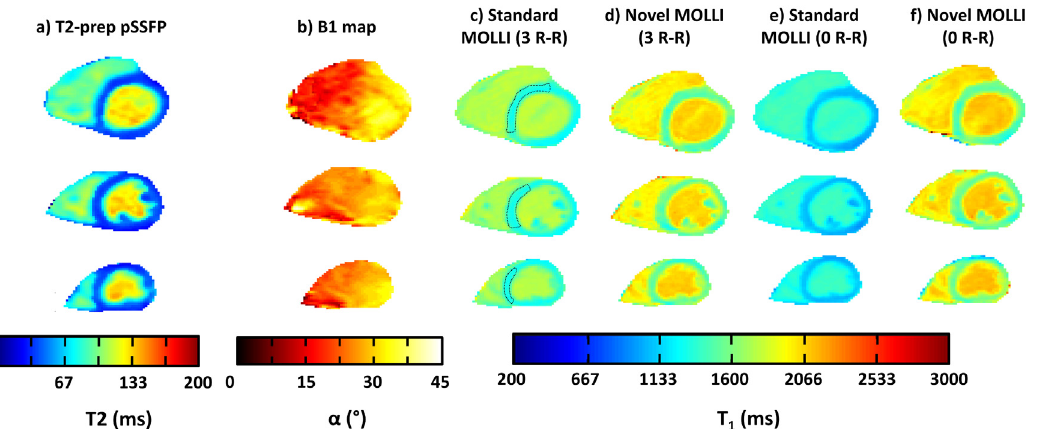
Fig 8. In vivo T2 and B1+ maps obtained using T2-prepared TrueFISP and Bloch-Siegert sequences, respectively (a and b). In vivo T1 maps generated from standard and novel post-processing approaches of the MOLLI sequence (3HB) (c and d respectively). In vivo T1 maps generated from standard and novel post processing of the MOLLI sequence acquired without recovery period before second and third inversions (0HB) (e-f).